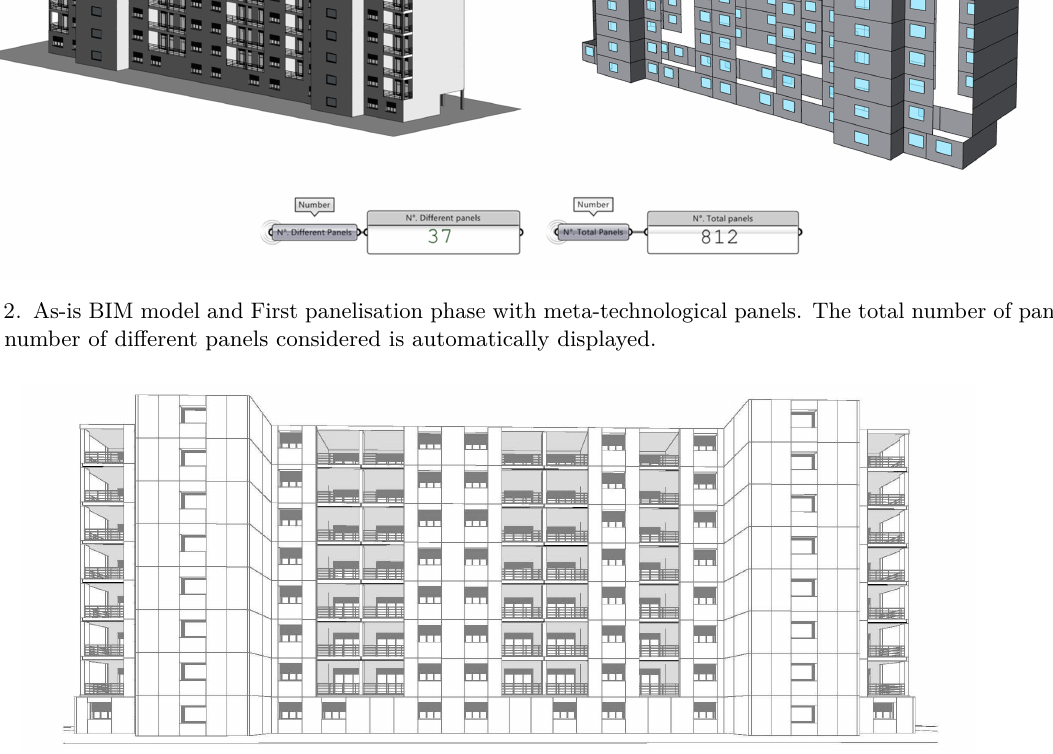
Figure 3. Perspective view of the BIM model with the selected